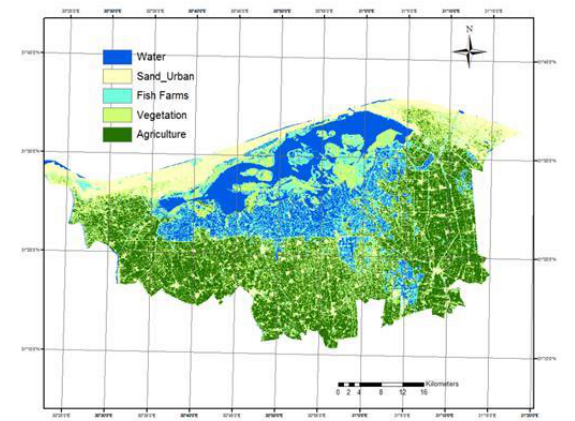
Figure (10) Classification Map Feb 2015